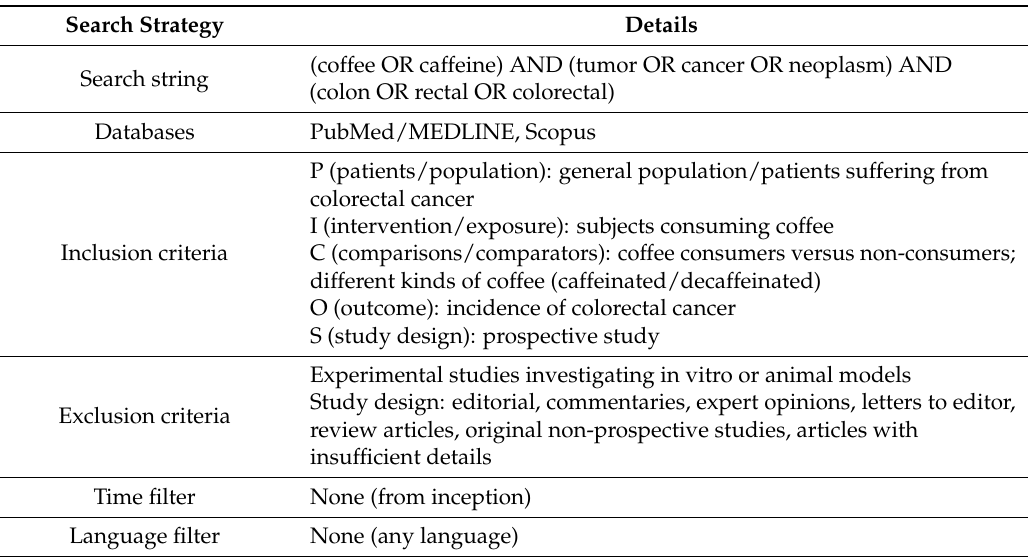
Table 1. Search strategy adopted in the present systematic review and